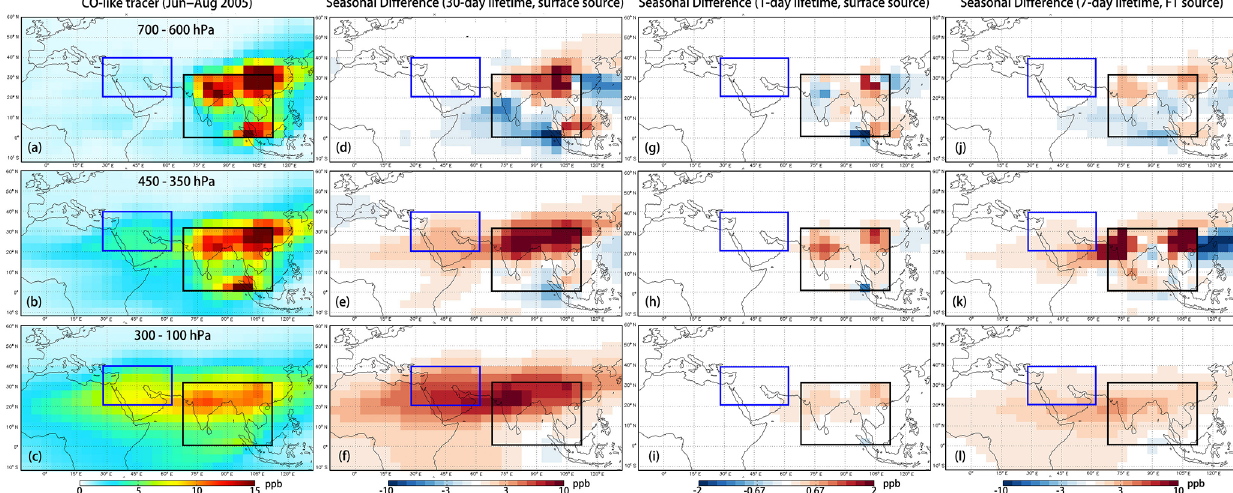
Figure 5. (a–c) Distribution of CO-like tracer (30-day lifetime) in June–August 2005 in lower free troposphere (700–600hPa), middle free tropospheric (450–350hPa) and upper free tropospheric (300–100hPa). The blue box defines the Middle East domain. The black box defines the region where CO was released from combustion sources only (fossil fuel, biofuel and biomass burning); (d–f) difference of CO-like tracer (30-day lifetime) concentration between June–August and March–May 2005. The CO emission in March–May 2005 is set as the same as that in June–August 2005; (g–i) difference of CO-like tracer (1-day lifetime) concentration between June–August and March–May 2005; (j–l) difference of CO-like tracer (7-day lifetime) concentration between June–August and March–May 2005; the combustion sources are released in middle free